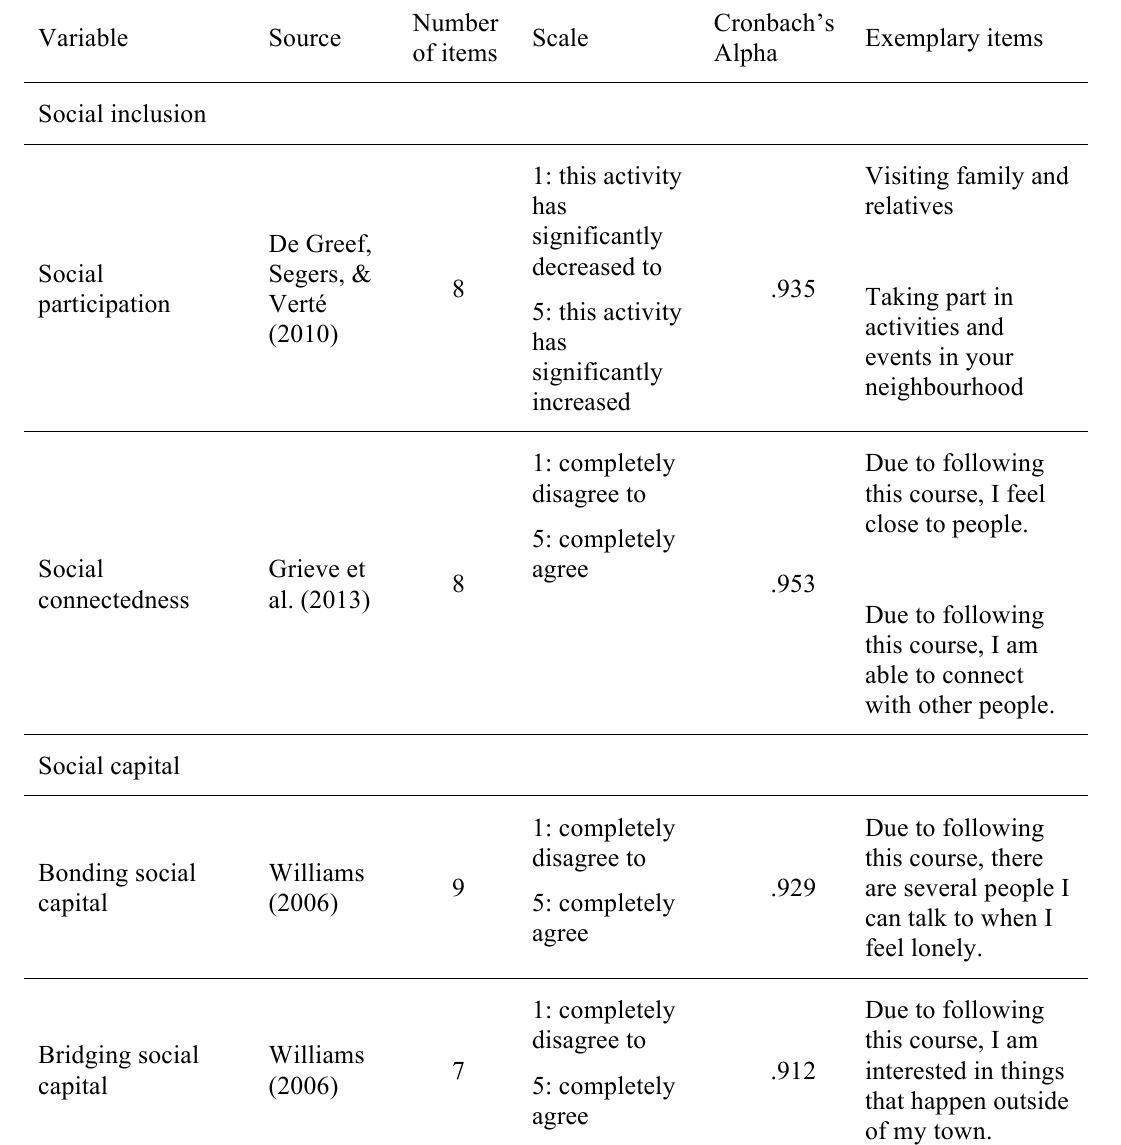
Table 2 : Instruments for measuring social inclusion and social capital. Data